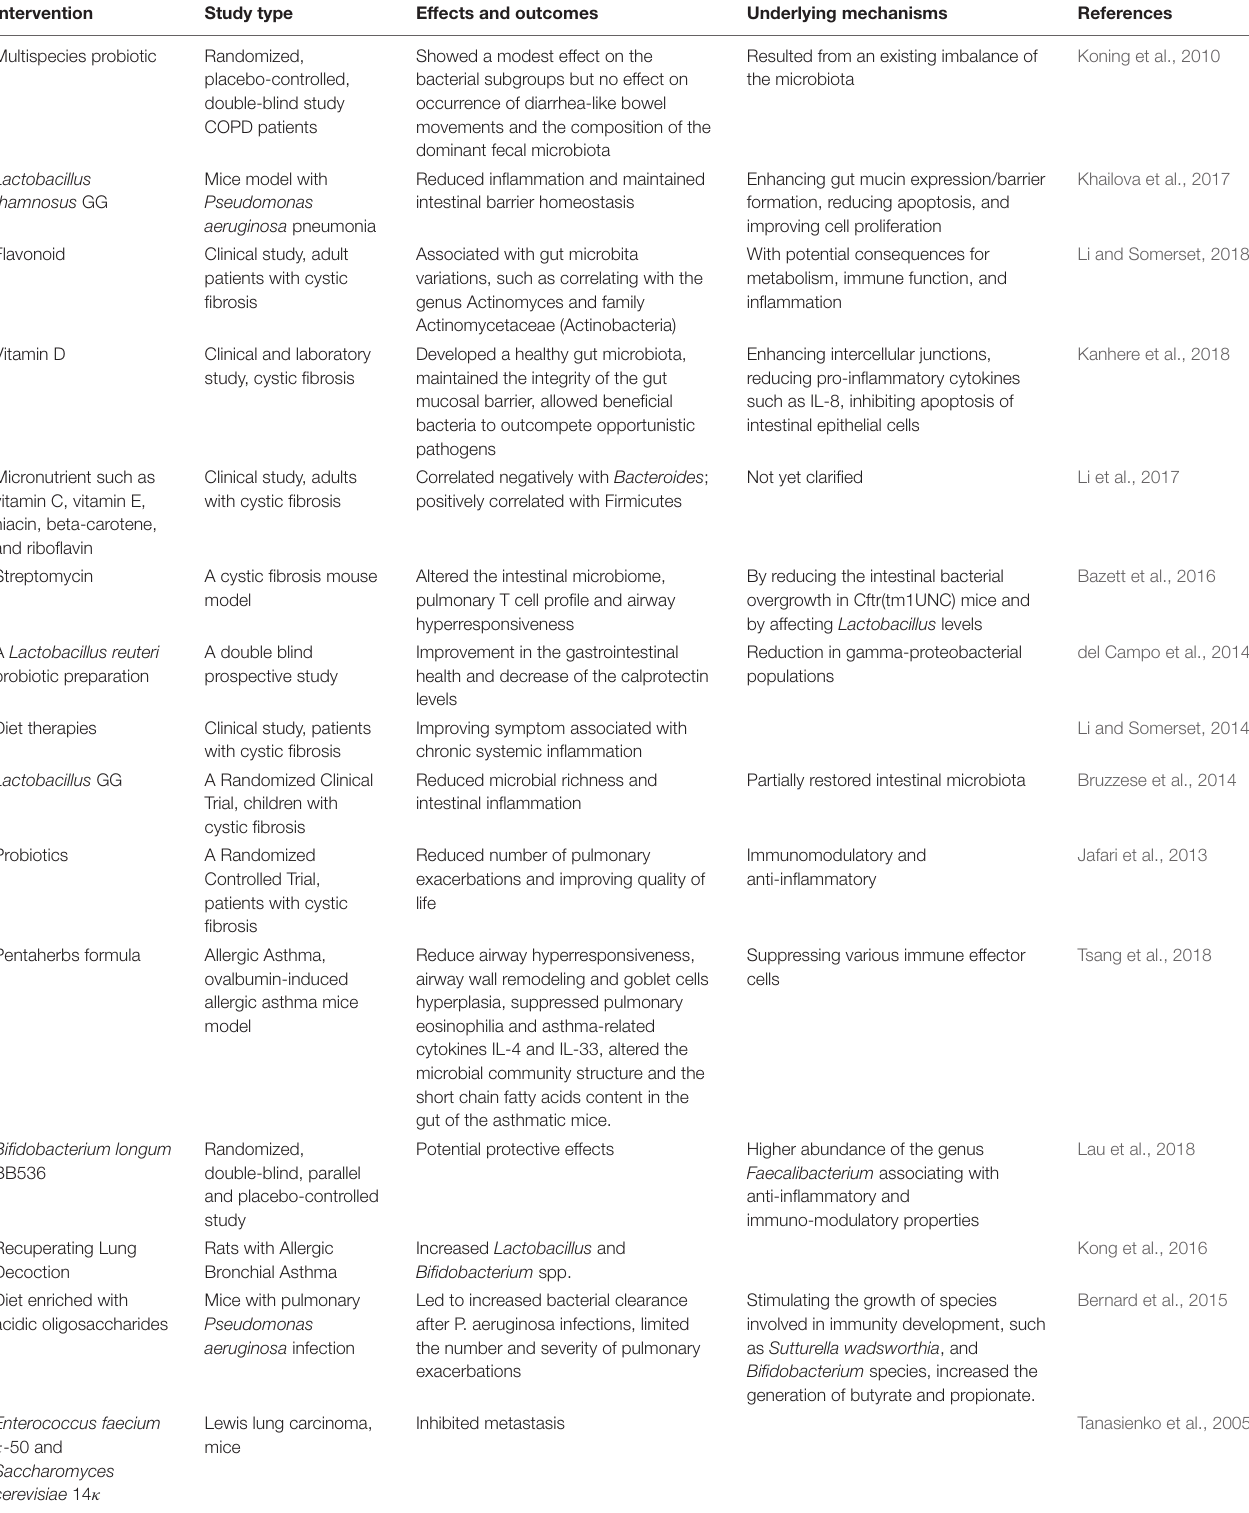
TABLE 1 | Interventions targeting manipulation of gut microbiota in lung